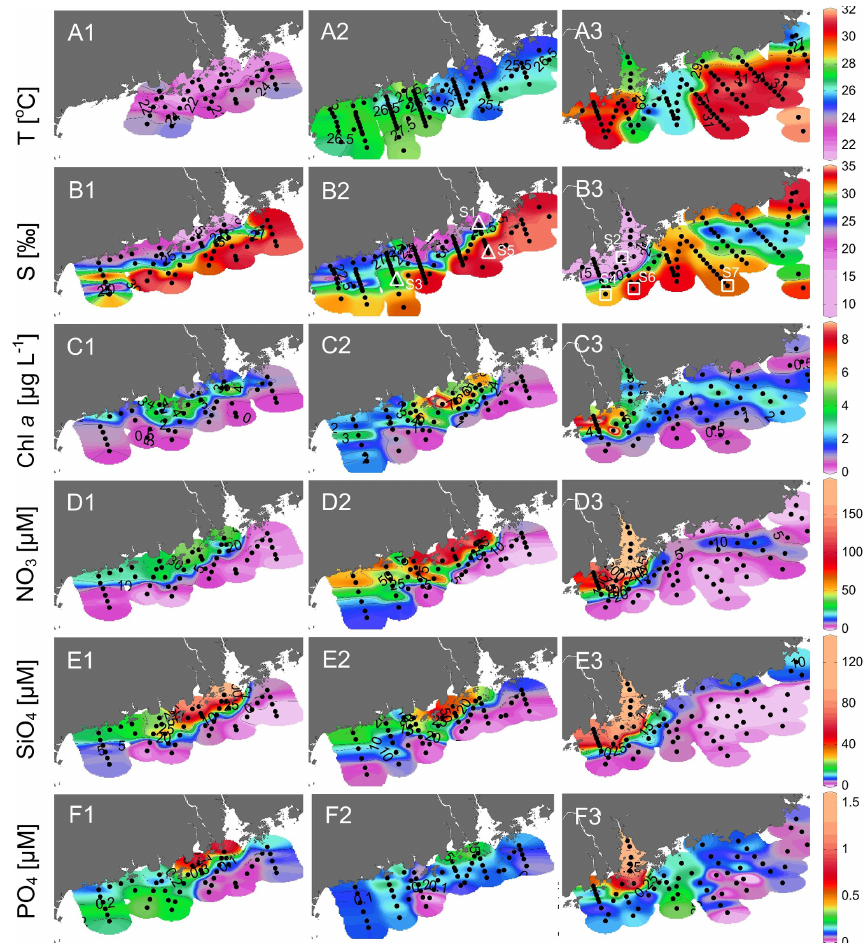
Figure 3. Surface distributions of (a1)–(a3) temperature, (b1)–(b3) salinity, (c1)–(c3) chlorophyll a , (d1)–(d3) nitrate, (e1)–(e3) silicate and (f1)–(f3) phosphate in the NSCS during April, May and June 2016. Small dots are the data points; open triangles and squares in (b2)–(b3) show the positions of